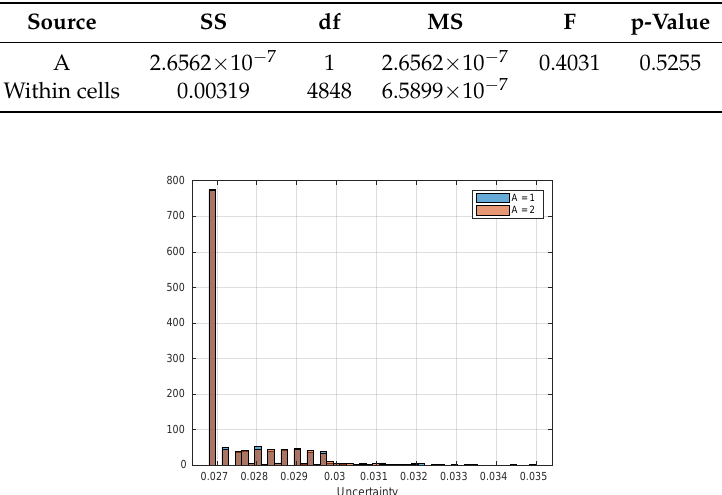
Figure A17. Histograms for the conclusion of the effect of factor A on the expected uncertainty performance when B = 2, represented for the two levels of factor A.